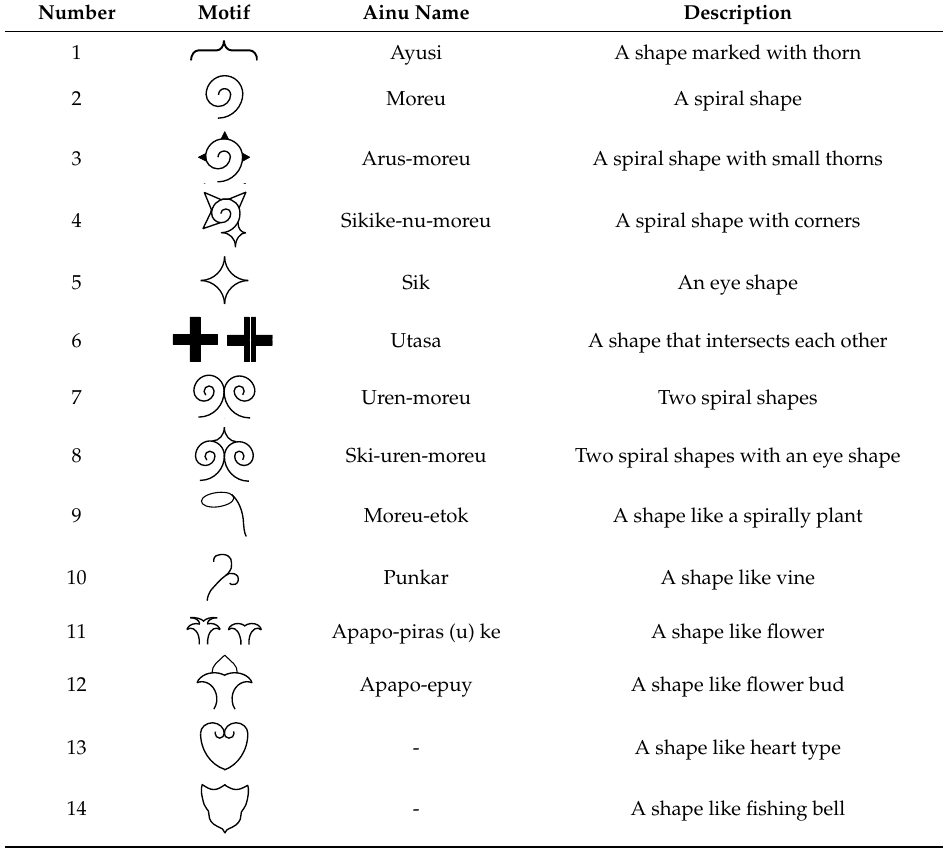
Table 1. Different types of Hokkaido-based Ainu motifs [64].